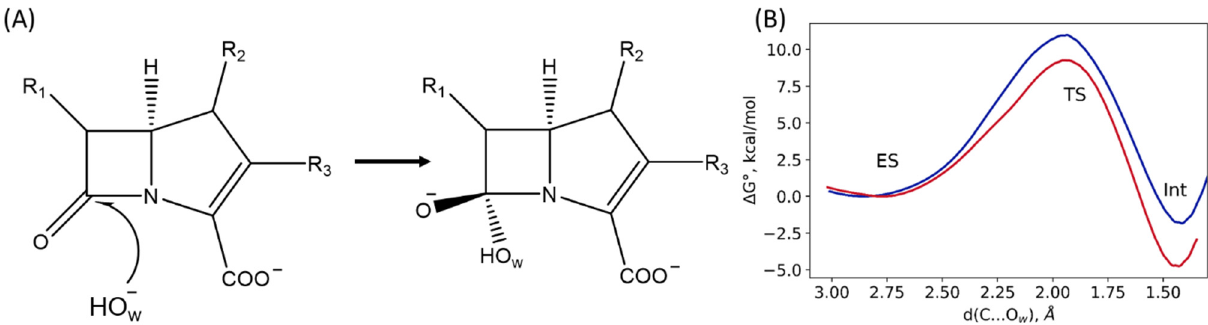
Figure 7. ( A ) Scheme of the first step of the reaction, black arrow indicates reaction coordinate of nucleophilic attack of the carbonyl carbon atom of the imipenem by the catalytic O w H − . ( B ) Gibbs energy profiles of the first step of the imipenem hydrolysis reaction in the active sites of the L1 (red, this study) and the NDM-1 (blue, ref. [20]).